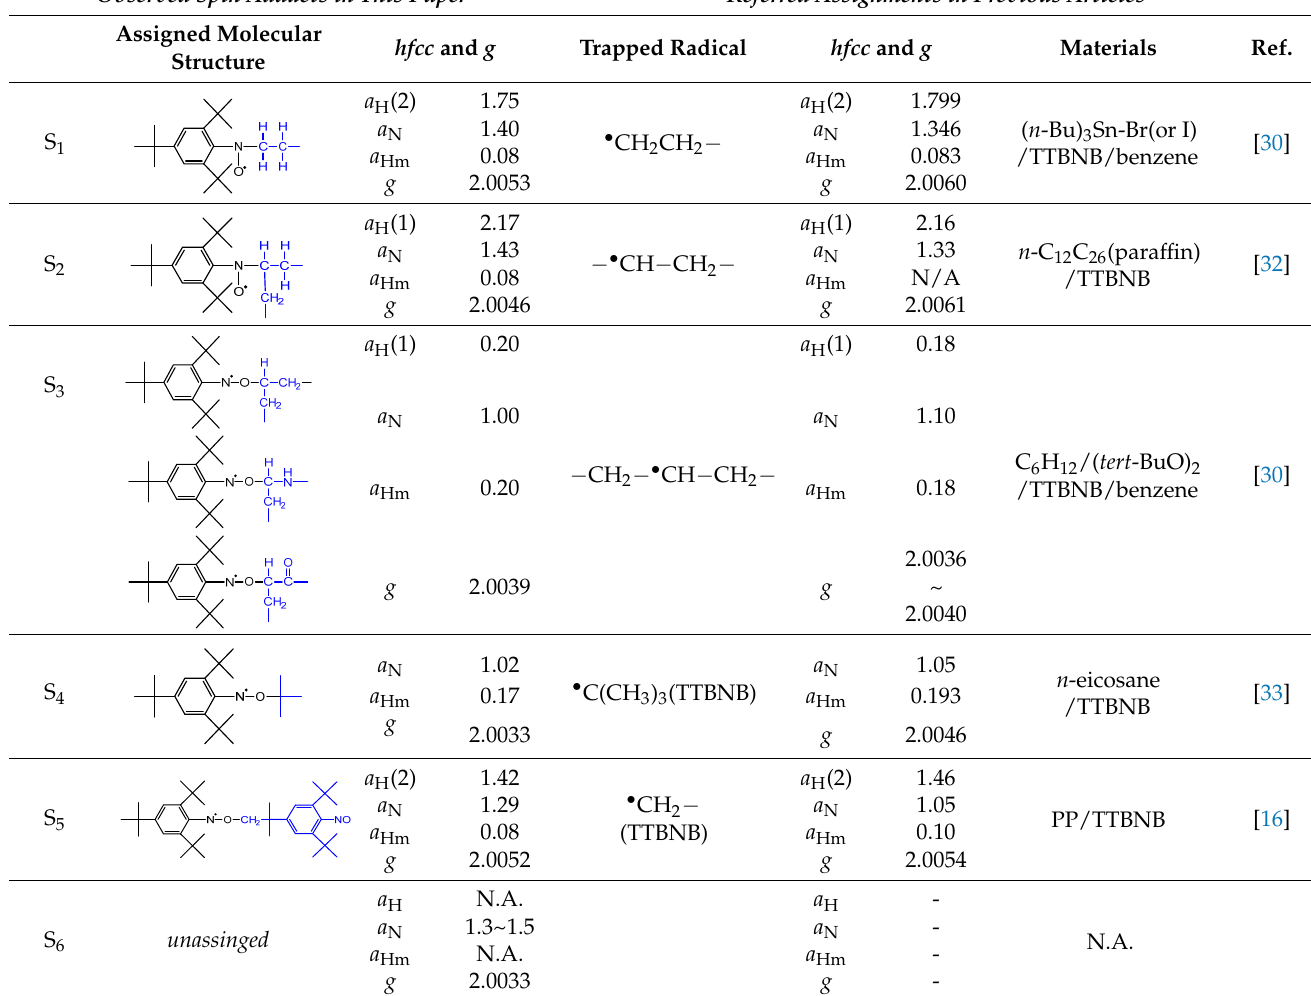
Table 2. The molecular structure of the assigned spin adducts, S 1 – S 6 , and their ESR spectral param- eters observed for PA66 with TTBNB heated from RT to 240 °C, as well as the literature referred to in assigning the spin adducts.